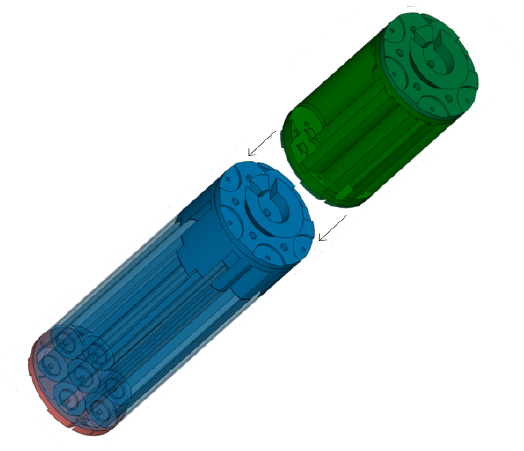
Figure 3. CAD Battery Blocks: top battery block (in green) corresponds to the 12 VDC preamplifier battery pack, bottom battery block (in blue) corresponds to the 6 VDC